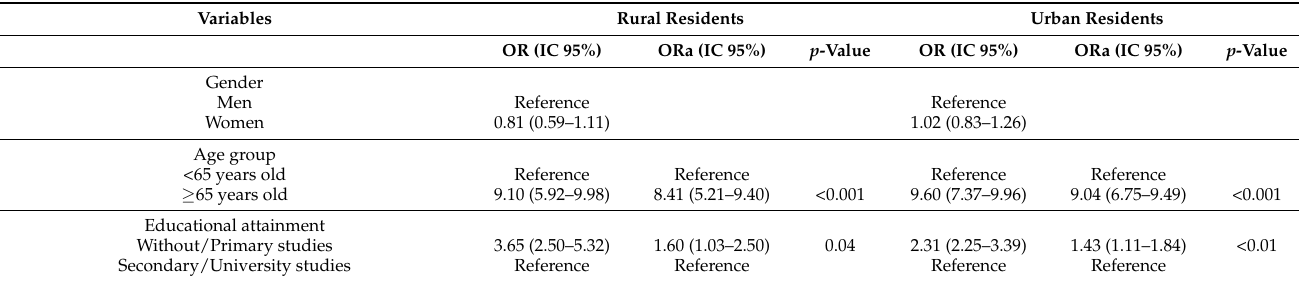
Table 3. Association between FL, sociodemographic factors and health-related determinants in rural and urban cancer patients ( n =